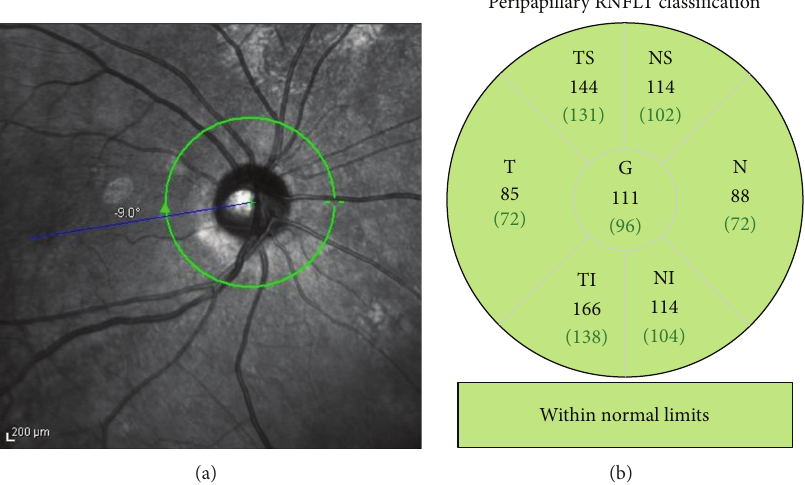
Figure 1: Global and sectoral retinal nerve fiber (RNFL) thicknesses before and after vitrectomy with ILM peeling for eyes with a macular hole (MH). (a) Peripapillary RNFL thickness was measured around the optic disc. (b) Sectoral analyses of the RNFL thickness were performed for the temporal/superior (TS, 1–45 degree), temporal (T, 46–135 degree), temporal/inferior (TI, 136–180 degree), nasal/inferior (NI, 181–225 degree), nasal (N, 226–315), and nasal/superior (NS, 316–360) sectors.